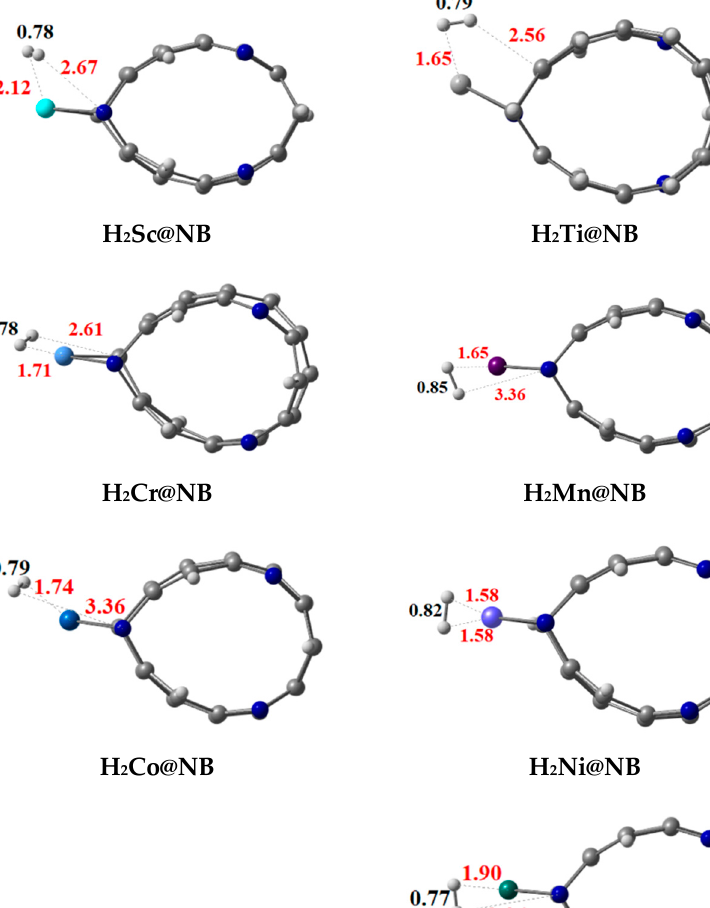
Table 2. Summary of hydrogen molecule adsorption energies ( Δ E ads ), energy of reaction ( Δ E),